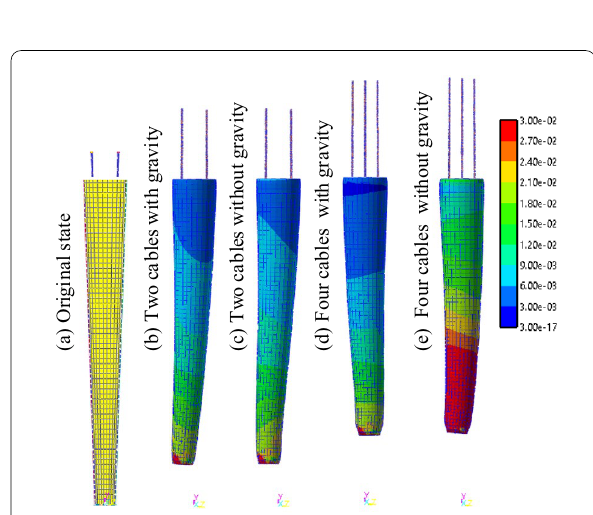
Figure 6 Simulation results of two cables driven and four cables driven constriction simulation